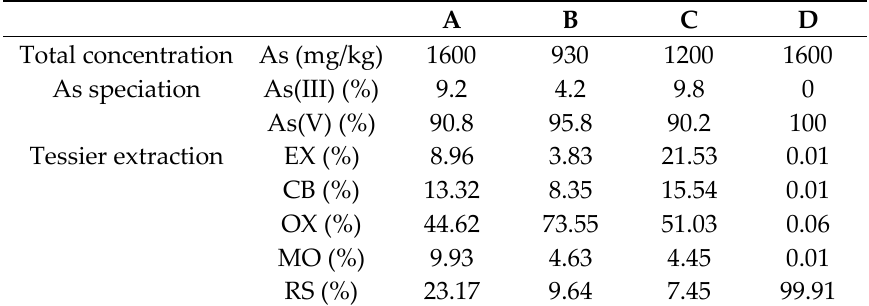
Table 1. Chemical results from arsenic affection